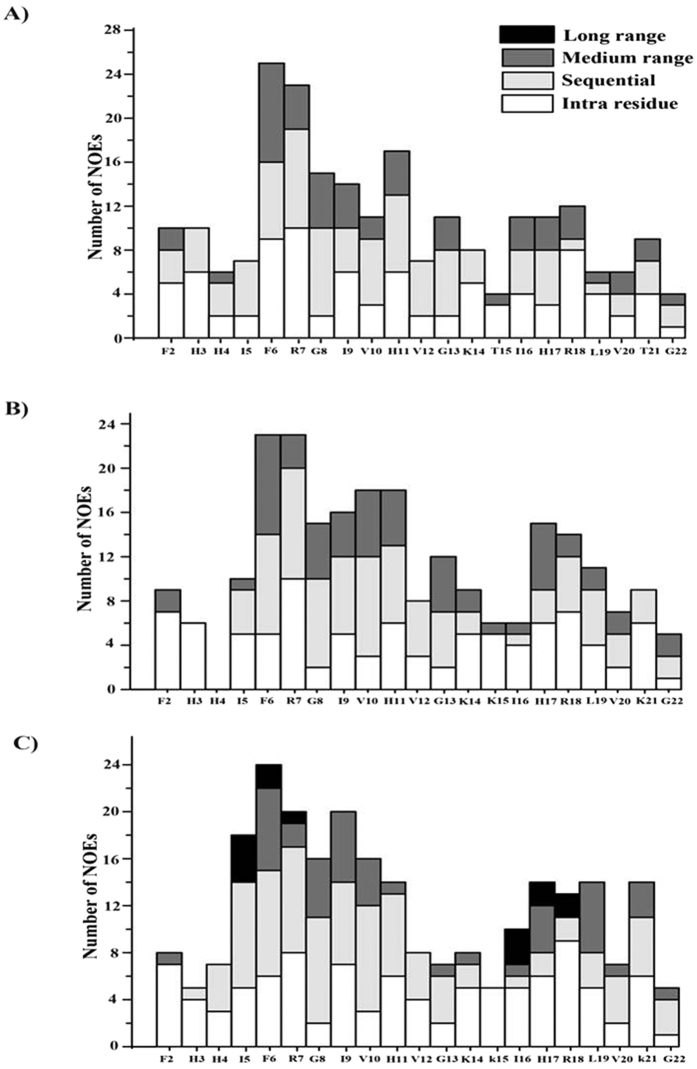
Bar diagrams summarizing type of NOEs observed for piscidin-1 (panel A), T15, 21K-piscidin-1 (panel B) and T15, 21dK-piscidin-1 (panel C) in LPS micelles.